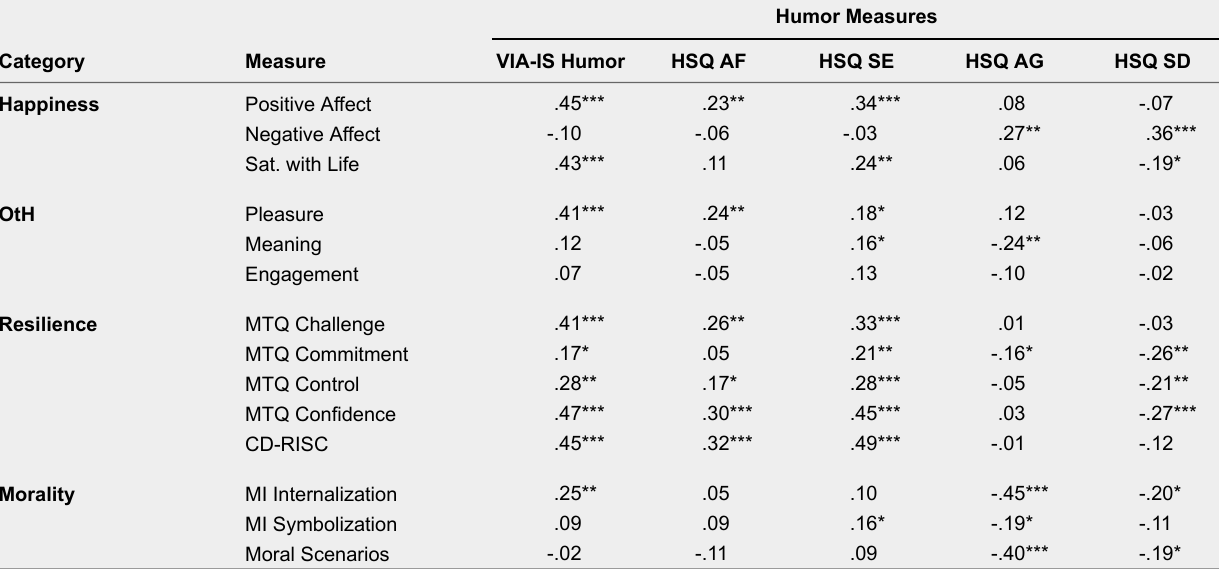
Simple Correlations Between the Humor Scales and Positive Psychology